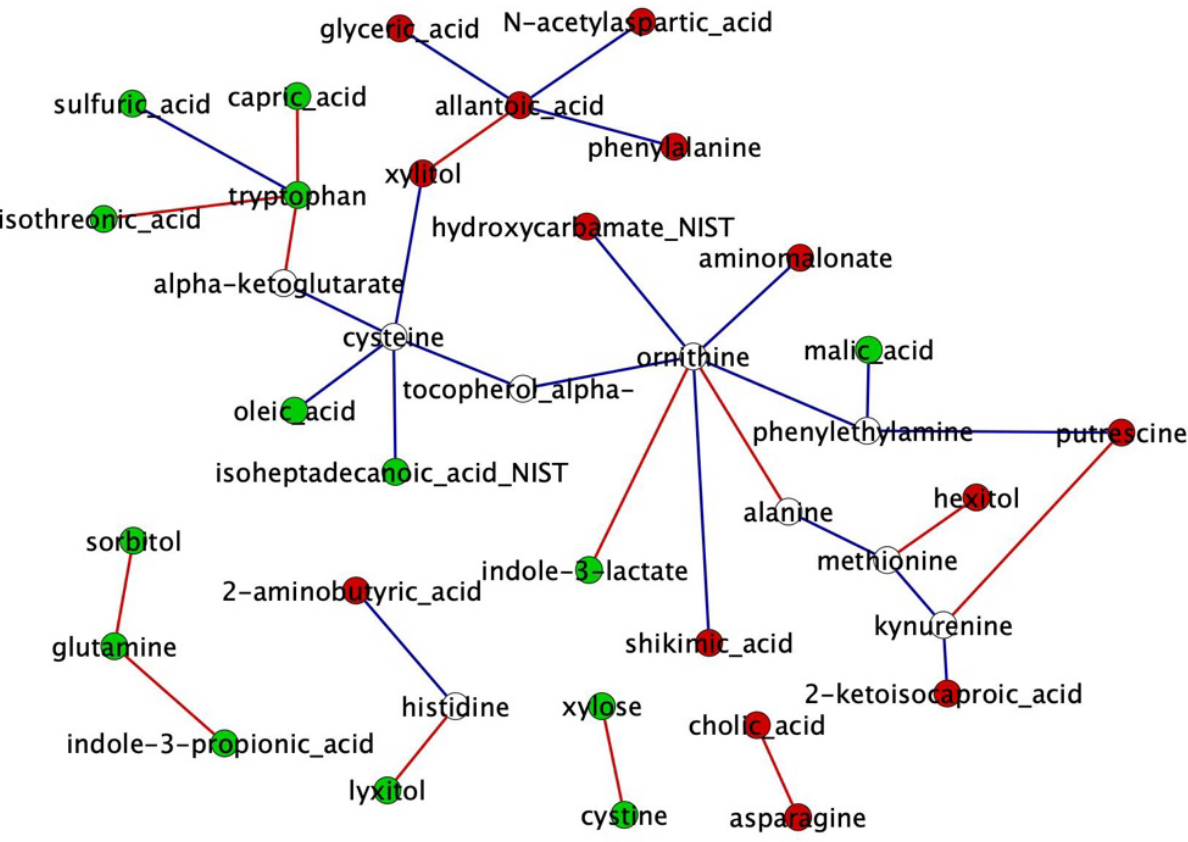
Figure 4. Metabolite network comparison based on rewired nodes (metabolites) from the AI-P and NP groups. A central reference network was constructed using DyNet in Cytoscape. The unique nodes are red (AI-P) or green (NP). Shared nodes between AI-P and NP are white. The edges are red (negative correlation) and blue (positive